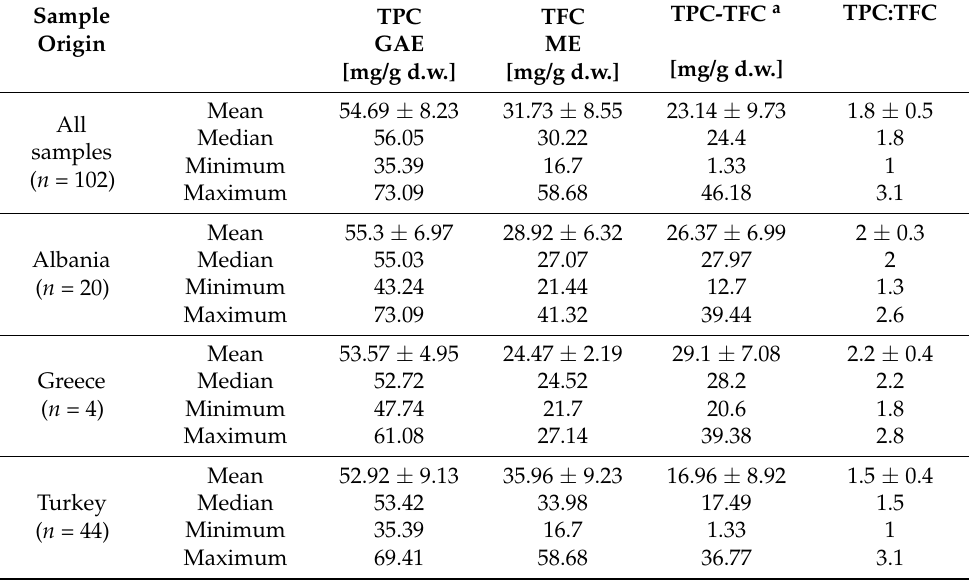
Table 1. Total phenolics (TPC), flavonoids (TFC), and non-flavonoid polyphenols (TPC-TF) in C. incanus water